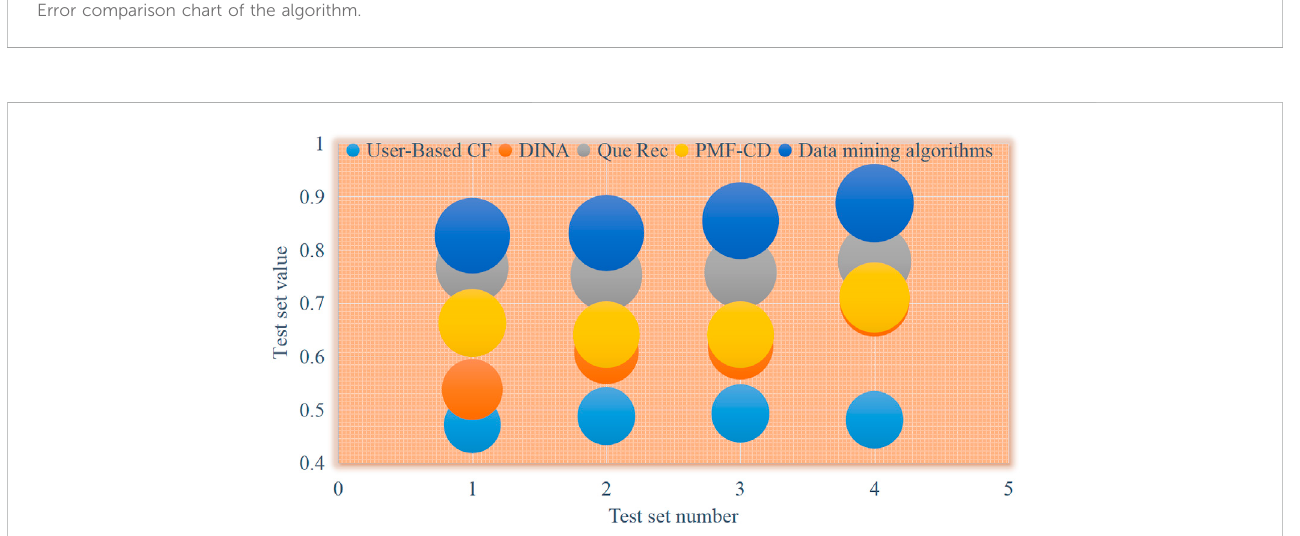
FIGURE 8 P1 value of simple stock market resource